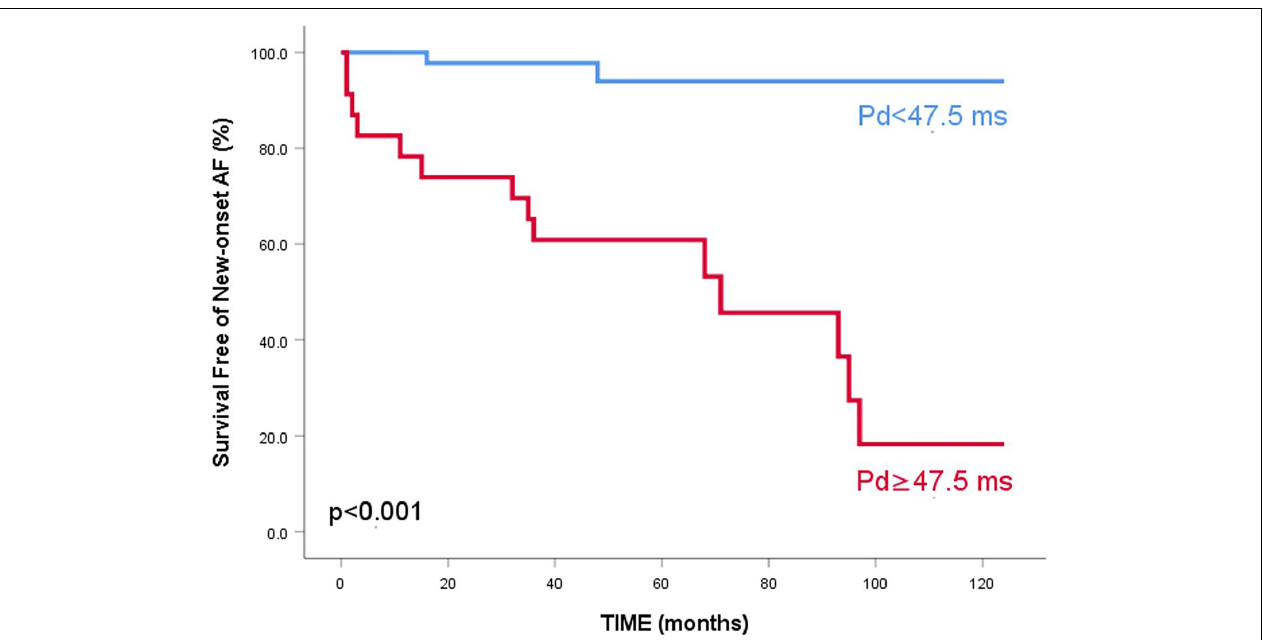
FIGURE 5 | Kaplan–Meier survival curve free of new-onset atrial fibrillation for HCM patients with LAD < 45 mm, stratified according to P wave dispersion – 5-year survival free of events of 94% vs 60.9%, p < 0.001.